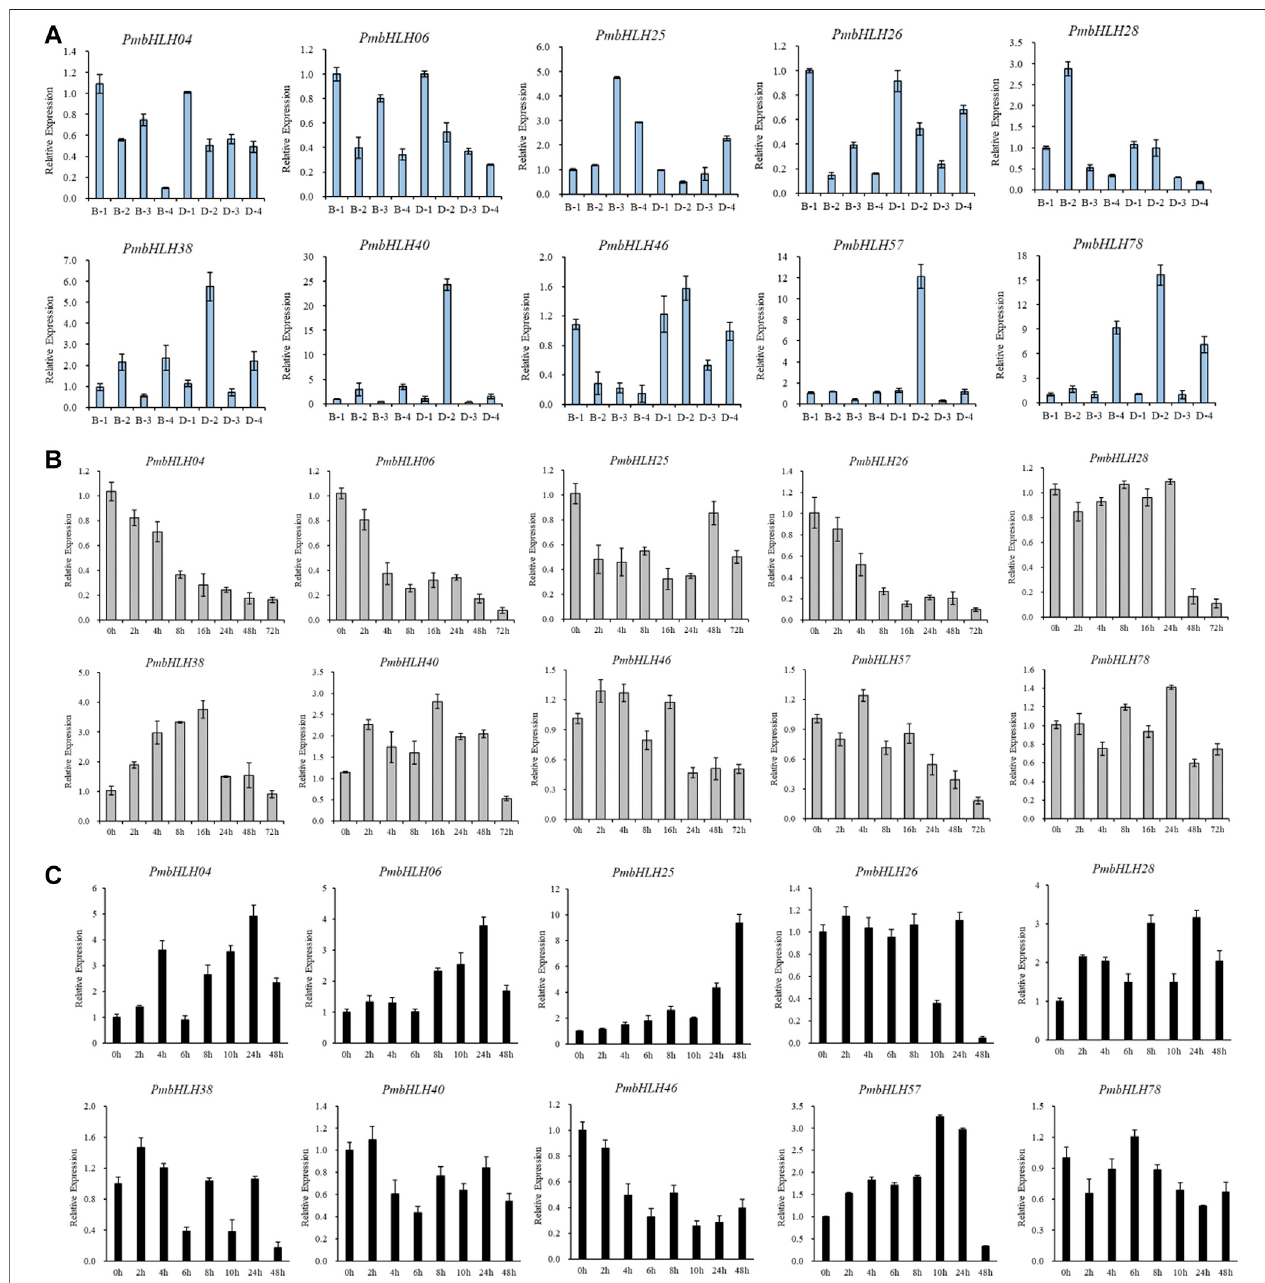
FIGURE 6 | Expression patterns of 10 candidate PmbHLHs in ‘ Beijing Yudie ’ and ‘ Danfenghou ’ under low-temperature treatments by qRT-PCR. (A) Expression patternsundercoldtreatment(4 ° Cfor8 hand5 days)andfreezingtreatment( − 5 ° Cfor1 h). “ 1 ” representedstemsthatweretreatedat25 ° C, “ 2 ” representedstemsthat were treated at 4 ° C for 8 h, “ 3 ” represented stems that were treated at 4 ° C for 5 days, “ 4 ” represented stems that were treated at − 5 ° C for 1 h. (B) Expression patterns exposed to cold treatment for different times (0/2/4/8/16/24/48/72 h). (C) Expression patterns exposed to freezing treatment for different times (0/2/4/6/8/10/24/ 48 h). The standard deviation of three independent replicates was represented by Error